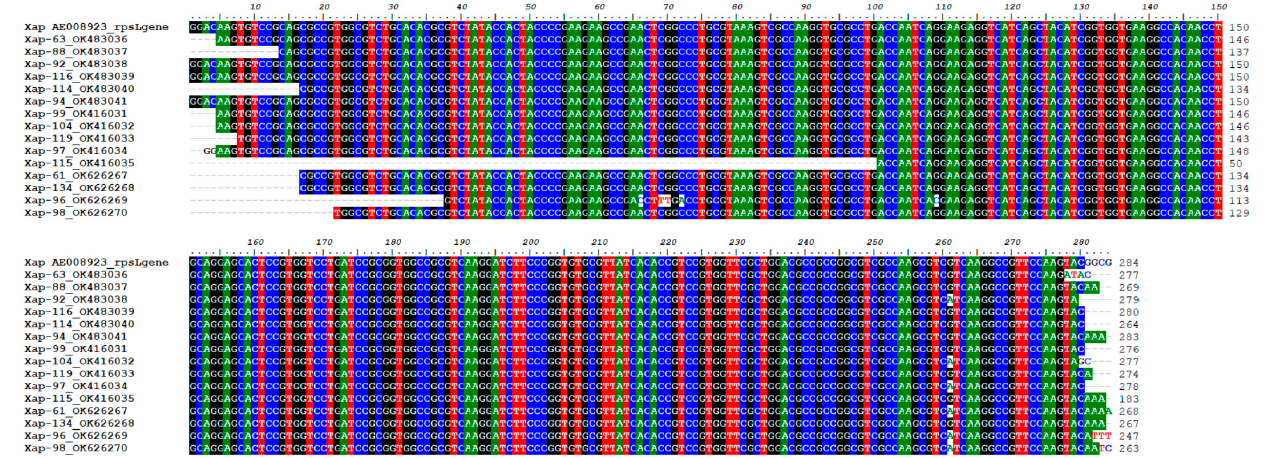
Figure 4. Relationship between percent disease severity (% DS) observed after 6 weeks and zone of inhibition (ZOI) at the highest concentration (1500 µg/mL).